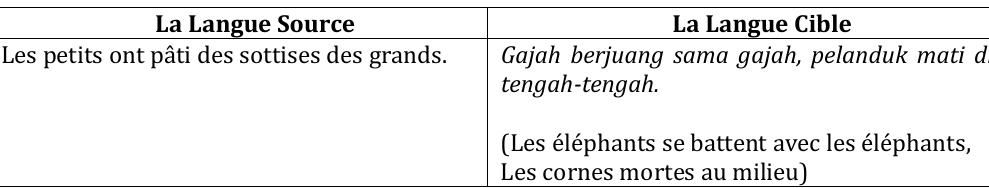
La Langue Cible